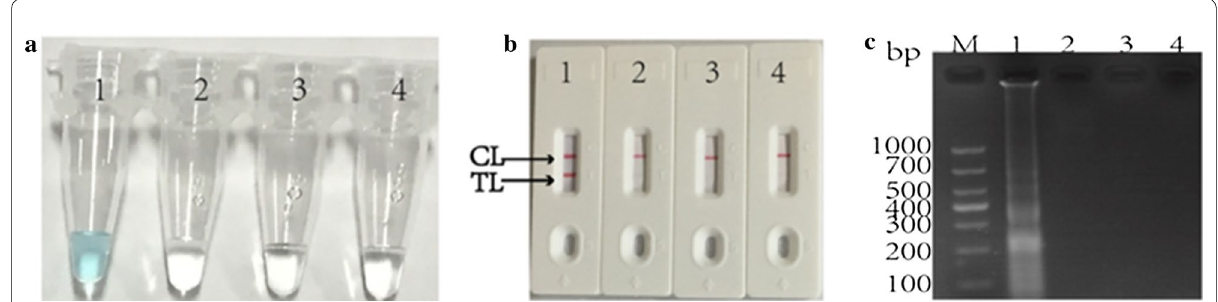
Fig. 2 Determining of A. baumanni -MCDA products. a 1.5 μL of Malachite Green added to 25 μL of MCDA reaction mixture before the MCDA reaction was used to identify amplification products of the A. baumanni -MCDA assay; b Lateral flow biosensor (LFB) applied for visual detection of